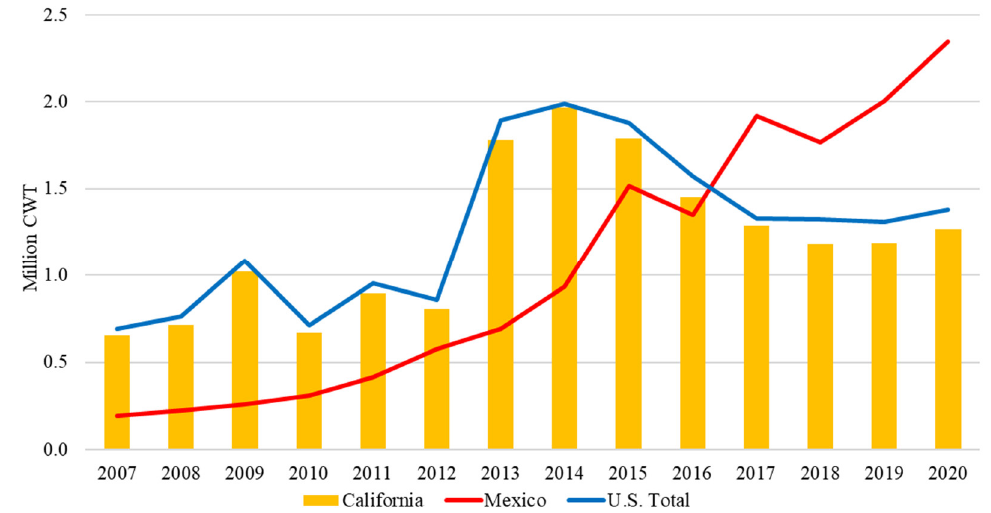
Figure 6. U.S. production and Mexican imports: fresh raspberry. Notes: The 2007 to 2013 U.S. production data are undisclosed and calculated from the available data. On average (2014–2020), 94% of the U.S. total production was from California, so 106% (calculated by 1 divided by 0.94) of the California production was used to represent the U.S. total production in the undisclosed years.